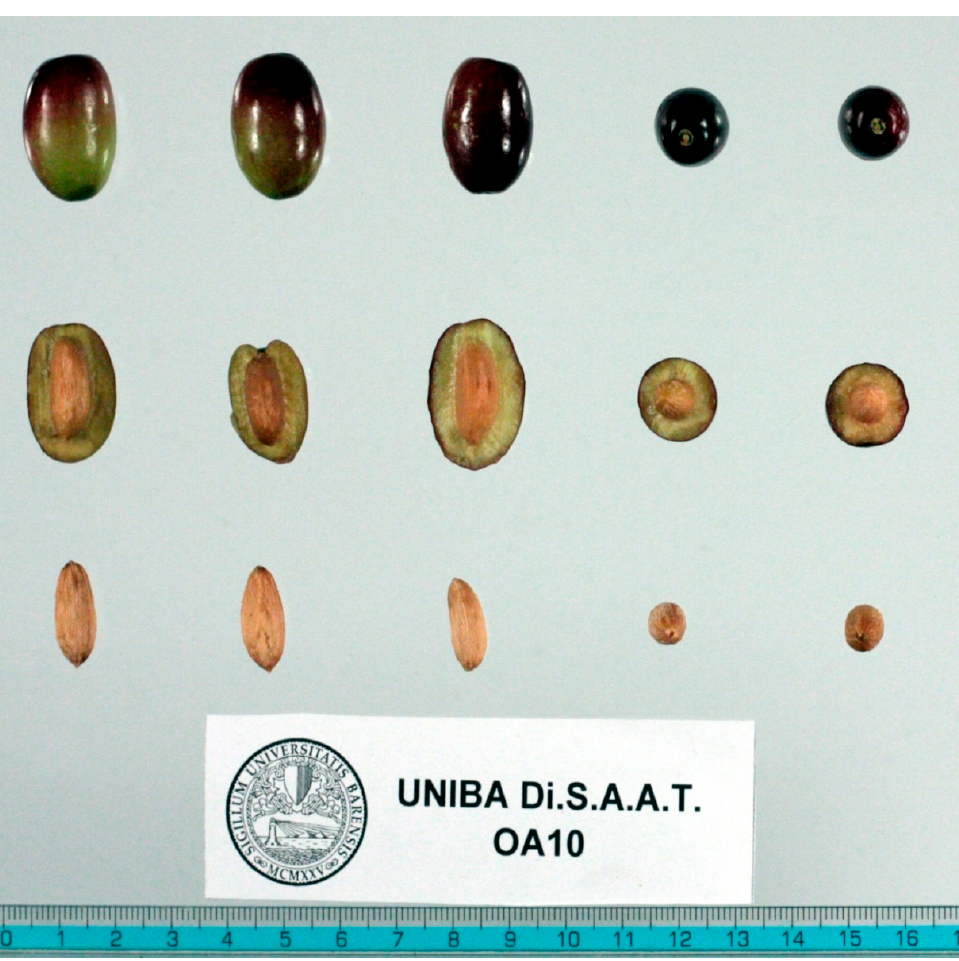
Figure 3. Fruit and stone of ‘Lecciana’.